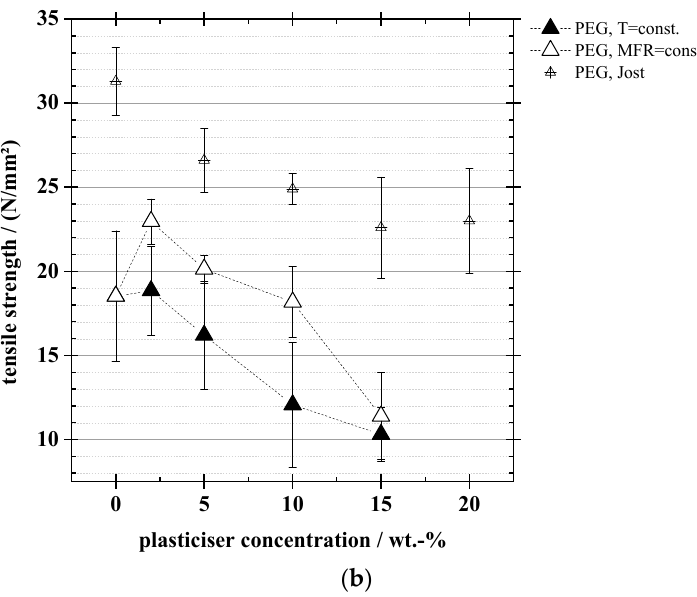
Figure 7. Tensile strength as function plasticizer concentration: ( a ) of triethyl citrate (TEC) concentration; ( b ) of polyethylene glycol (PEG) concentration. Comparison with results of Jost. MFR: melt flow rate during extrusion; T: temperature during extrusion.